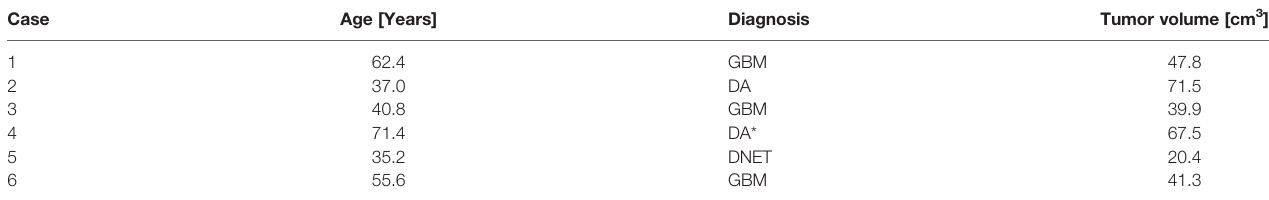
TABLE 1 | Patient characteristics and tumor